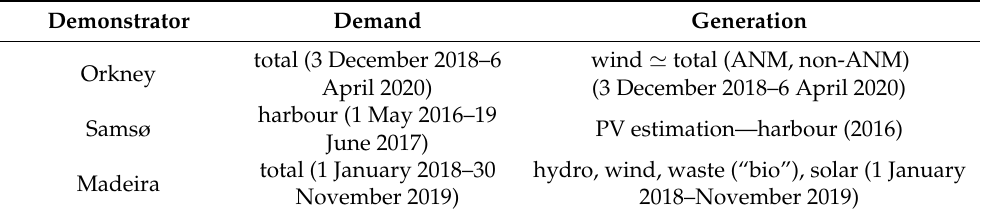
wind (cid:39) total (ANM, non-ANM)